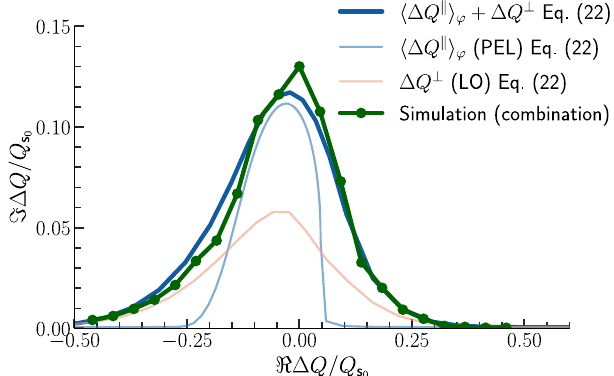
FIG. 6. Stability diagrams for the head-tail mode l ¼ 0 from Eq. (22) for LO (transverse detuning Δ Q ⊥ line), for a PEL (longitudinal detuning h Δ Q k y ð J line), and for the related combination (dark-blue line). The corresponding simulation results for the device combination are shown by the green